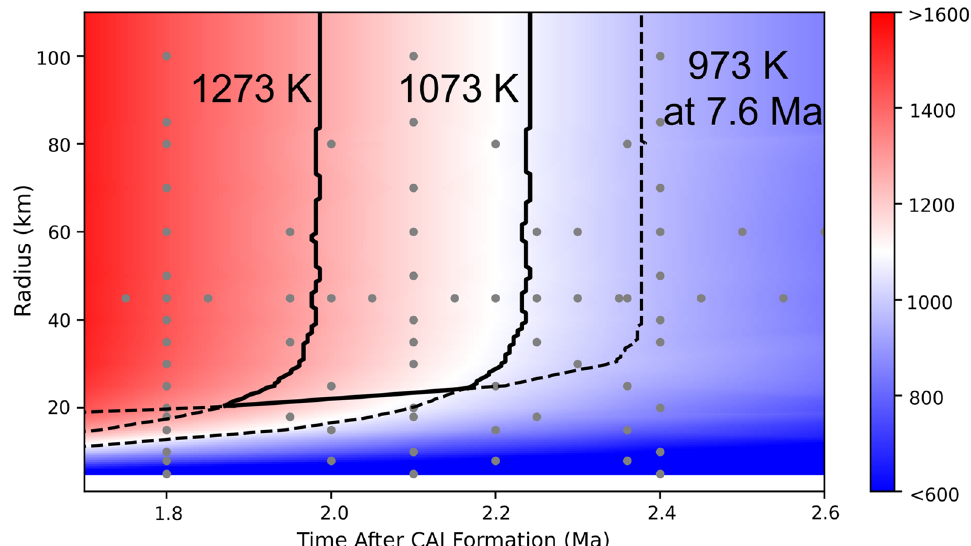
Fig. 1 Constraining Itokawa’s parent body without parameter uncertainty. The range of possible formation time and radius values for an Itokawa-like parent body following the methods of Wakita et al. (2014) with no uncertainties in model parameters taken into account. The gray dots are locations in the free parameter space at which simulations were performed. The peak central temperatures achieved in these simulations were linearly interpolated to create the color map pictured. Two of the isotherms shown correspond to 1073 and 1273 K on the peak central temperature map shown in color, and the third isotherm corresponds to 973 K on a map of central temperatures at 7.6 Ma which is not